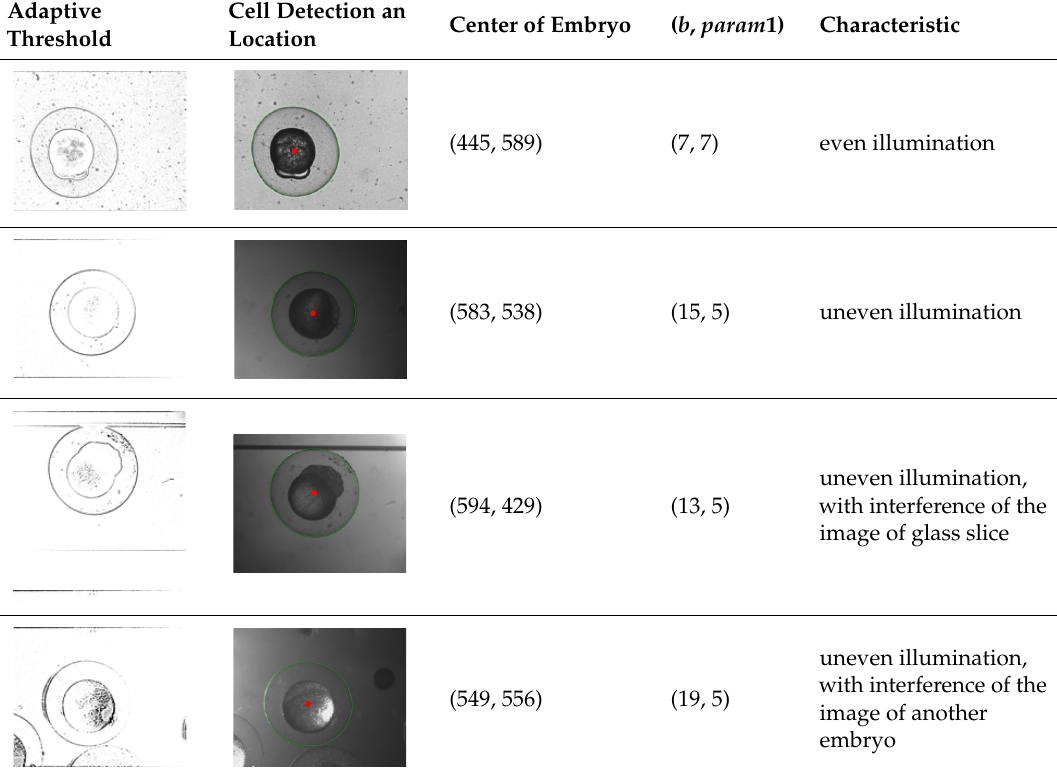
Table 3. Image processing of real-time video images.